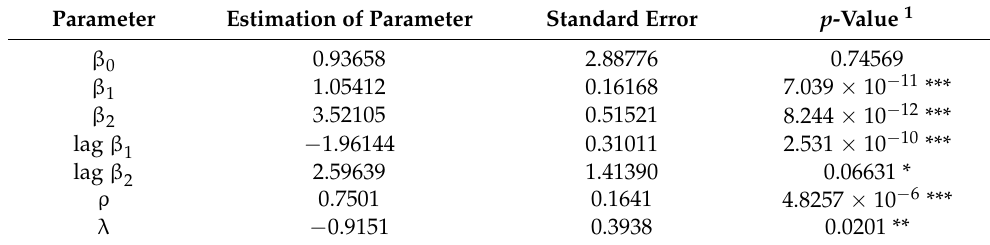
Table 3. Estimation results of the Manski spatial model (GNS—Formula